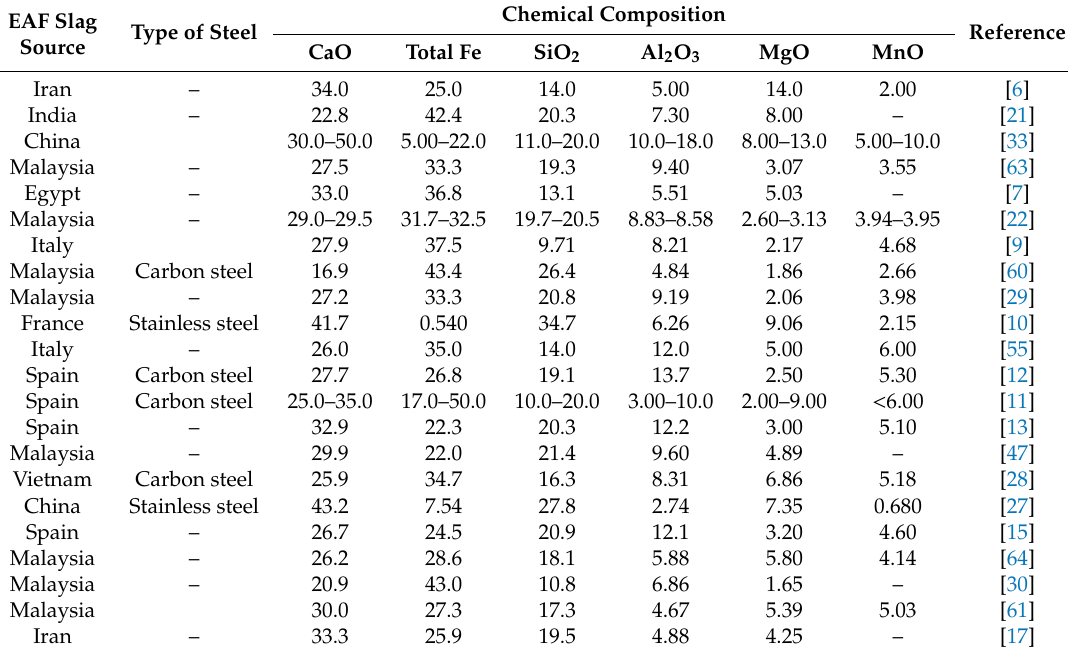
Table 2. Typical chemical composition of EAF slag reported by several